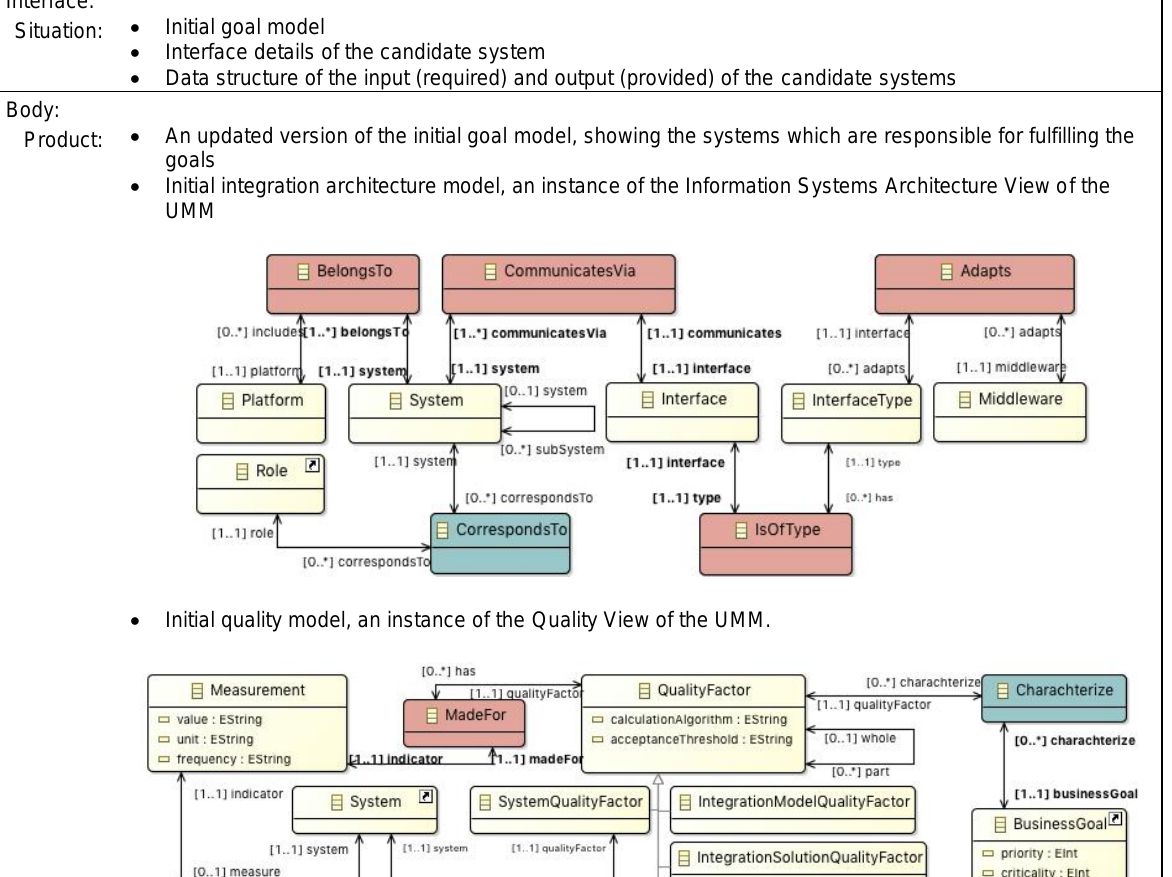
Initial goal model Interface details of the candidate